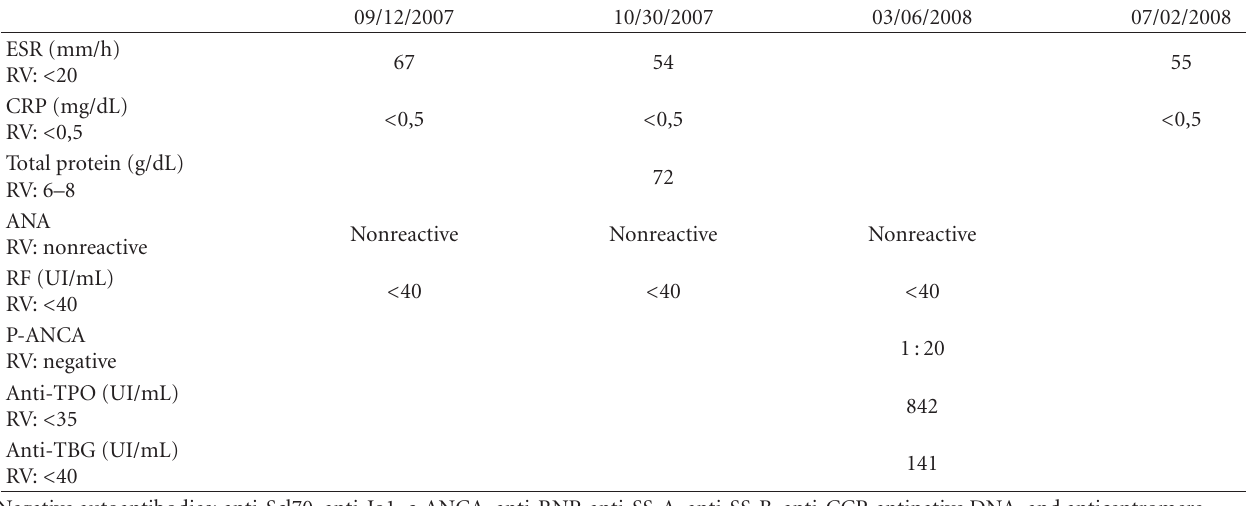
Table 2: Inflammatory activity tests and serologic and autoantibodies